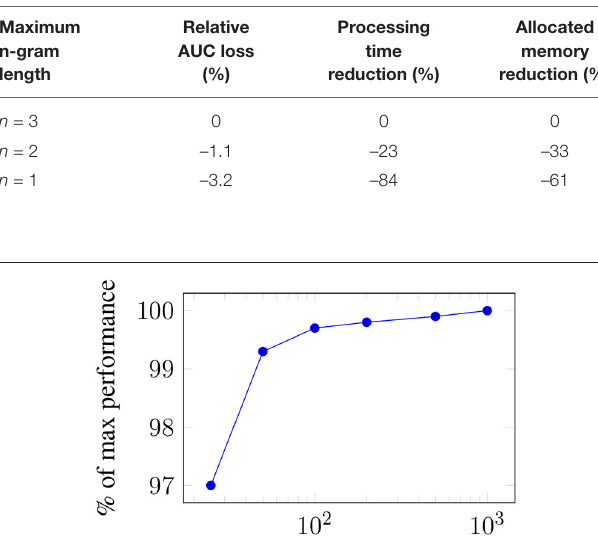
TABLE 12 | Average performance loss across all the targets and the decrease in the resources required for various maximum n-gram lengths.